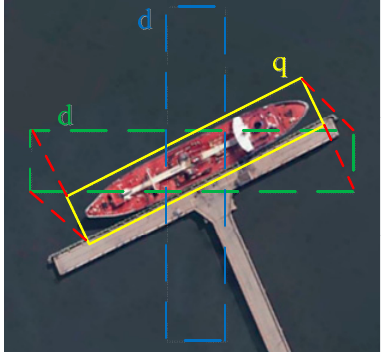
Sensors 2019 , 19 , x